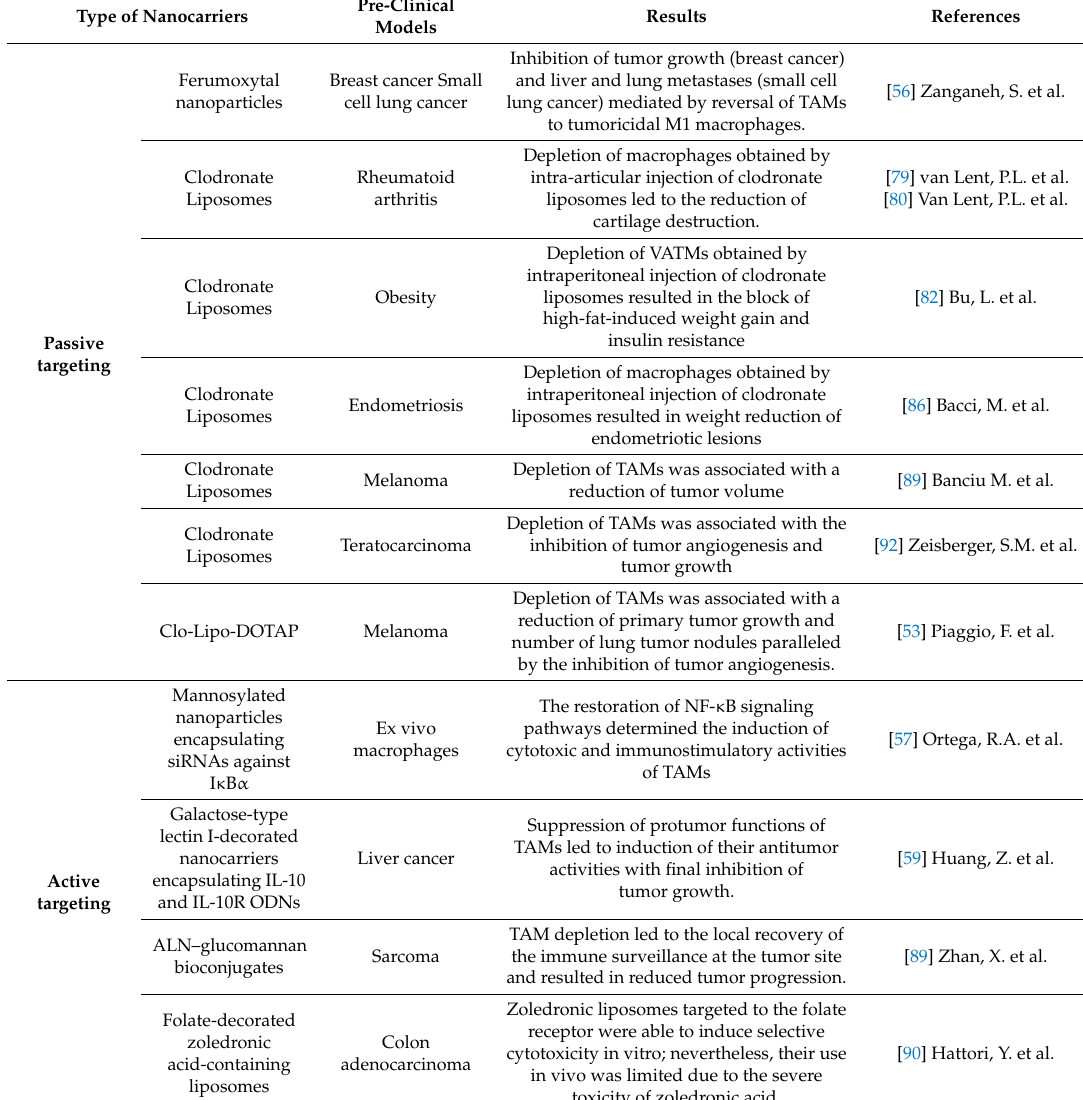
Table 3. Nanotechnology-based systems and macrophage manipulation in preclinical models. ODNs: